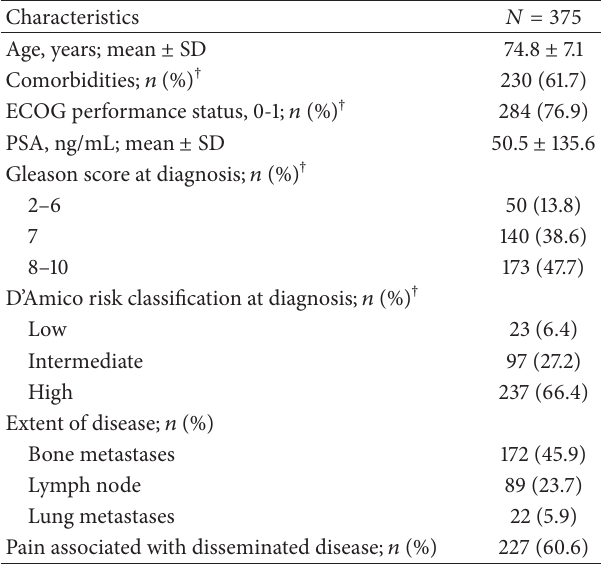
Table 1: Patient characteristics and disease status at diagnosis and at data